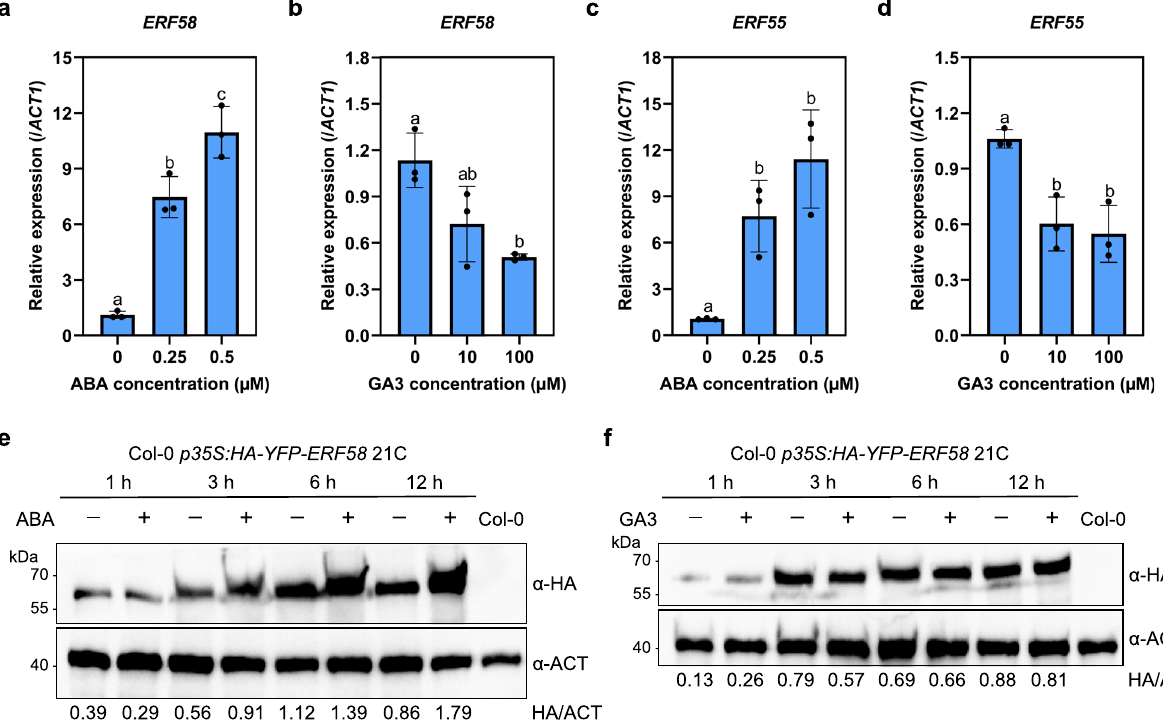
Fig. 8 ABA and GA regulate ERF55 and ERF58 expression. a – d RT-qPCR analysis of ERF58 ( a , b ) and ERF55 expression ( c , d ) in seeds incubated in the dark for 12 h on different concentrations of ABA ( a , c ) or GA3 ( b , d ). ACT1 was used as an internal control. Values show means of three replicates ±SD. Different letters indicate signi fi cant differences as determined by one-way ANOVA followed by post-hoc Tukey ’ s HSD test; p < 0.05. e , f Effect of ABA and GA3 on HA-YFP-ERF58 protein levels in ERF58ox seeds. Col-0 p35S:HA-YFP-ERF58 (line 21C) seeds were incubated in the dark on 0.5 μ M ABA ( e ) or 100 μ M GA3 ( f ) for 1, 3, 6, or 12 h. Control seeds were incubated on water. Total protein was extracted and analysed by SDS-PAGE and immunoblotting with α -HA; α -ACT was used to detect ACTIN as loading control. Col-0 was included as negative control. Signals detected by α -HA and α -ACT were quanti fi ed using ImageJ; numbers below the membrane show the HA/ACT ratio. The experiments were repeated three times with similar